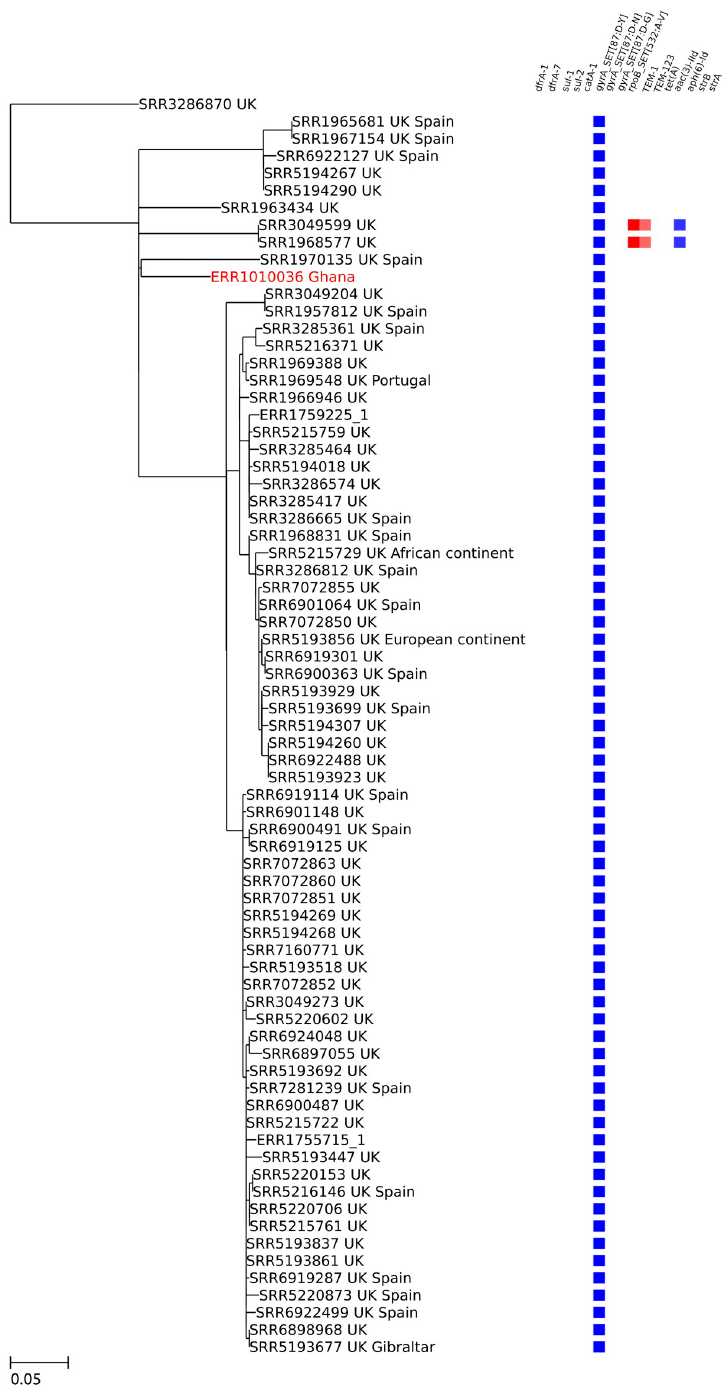
Fig 4. Zoomed-in maximum likelihood tree showing the Spanish travel-associated sub-clade of the global epidemic clade. One Ghanaian human bloodstream isolate was related to this sub-clade and is highlighted in red. Each isolate in the tree is represented by its accession number followed by the country of origin. In the case of PHE isolates, second countries listed after the country of origin represent reported travel destinations. A heatmap showing the resistance genes present in each isolate is displayed on the right. The gyrA 87:D-Y mutation (shown as a blue box) is present in every isolate of this sub-clade. The scale bar shows nucleotide substitutions per site.